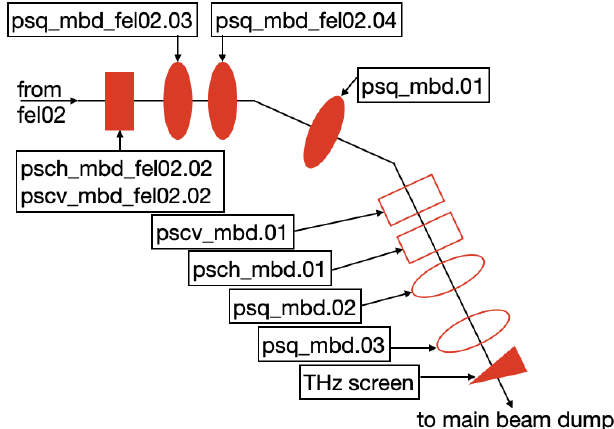
FIG. 7. Synoptic layout of the beam line after FEL02 showing the magnetic elements used for the optimization (filled shapes) and the magnetic elements left at their nominal values (empty shapes). The two bends are shown as vertices in the line.